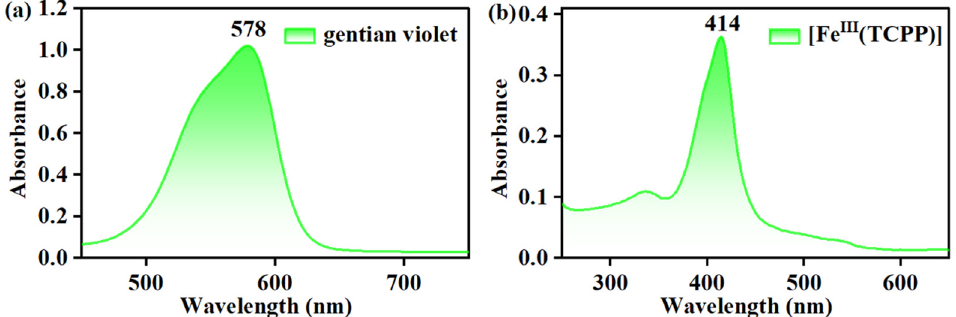
Figure 2. UV–vis spectra of gentian violet ( a ) and [Fe III (TCPP)] in MeOH ( b ).